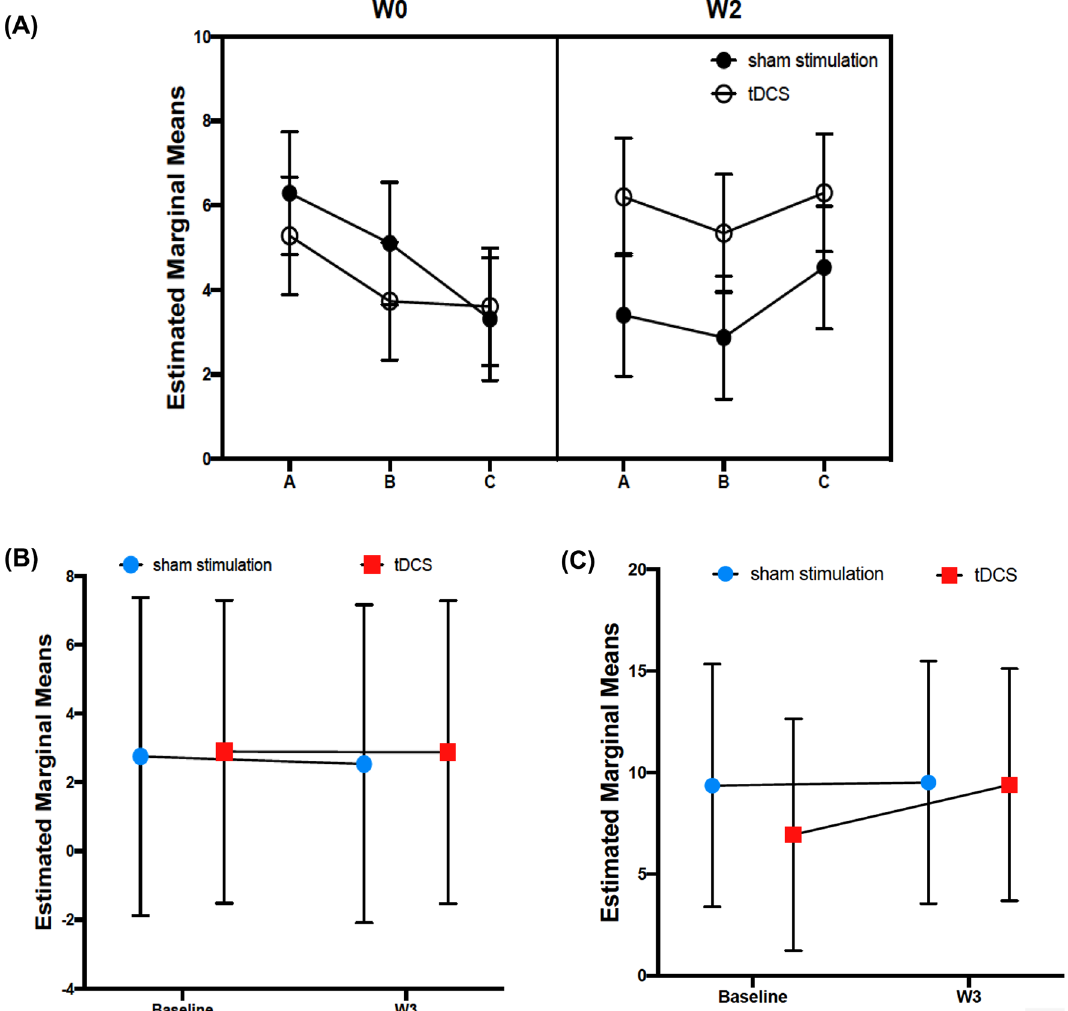
Figure 3. Secondary outcomes; estimated marginal means (cortisol concentration in nmol/L) were calculated in each model. ( A ) Presents the stimulation-related cortisol concentrations for tDCS and sham stimulation groups. Here, we present cortisol concentrations immediately before stimulation ( A ), immediately after stimulation ( B ), and two hours after stimulation ( C ) for W0 and W2 (Table 3). ( B ) Presents the cortisol awakening response (CAR) of both tDCS and sham stimulation groups for baseline and W3. Finally, ( C ) presents cortisol decline for both tDCS and sham stimulation groups for baseline and